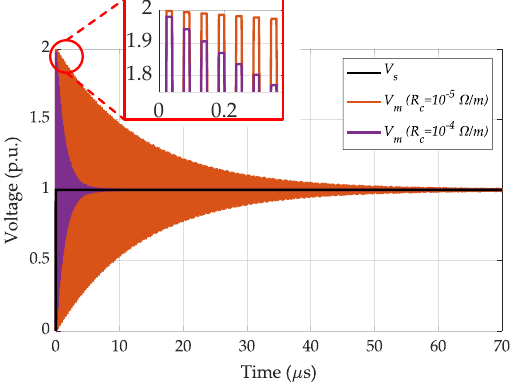
Figure 7. The voltage at motor terminals ( 𝑉 𝑚 ) when the motor is connected to the inverter through a cable with 𝑙 = 2 m and fed by a step voltage with 𝑡 𝑟 = 10 ns.